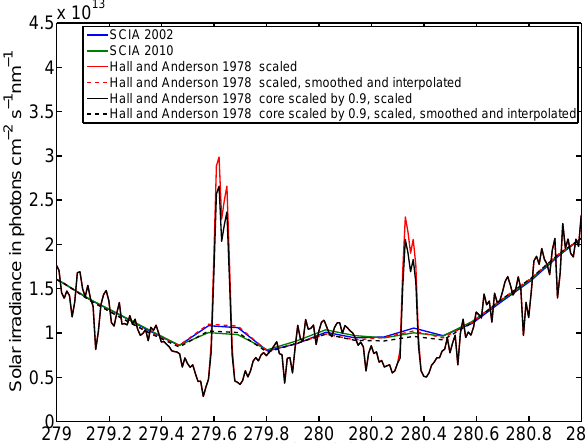
Fig. 12. SCIAMACHY solar spectrum in the Mg + double line re- gion for low (2010) and high (2002) solar activity in comparison with the scaled high resolution reference spectrum. When the high resolution spectrum is smoothed and sampled as the SCIAMACHY spectrum, there are only small differences left between both, mainly resulting from different phases of the solar cycle for the different spectra. An adjustment for the solar phase is done by scaling the core of the emission lines. The adjustment has to be done for each line individually. Possible variations of the inner structure of the emission lines are not